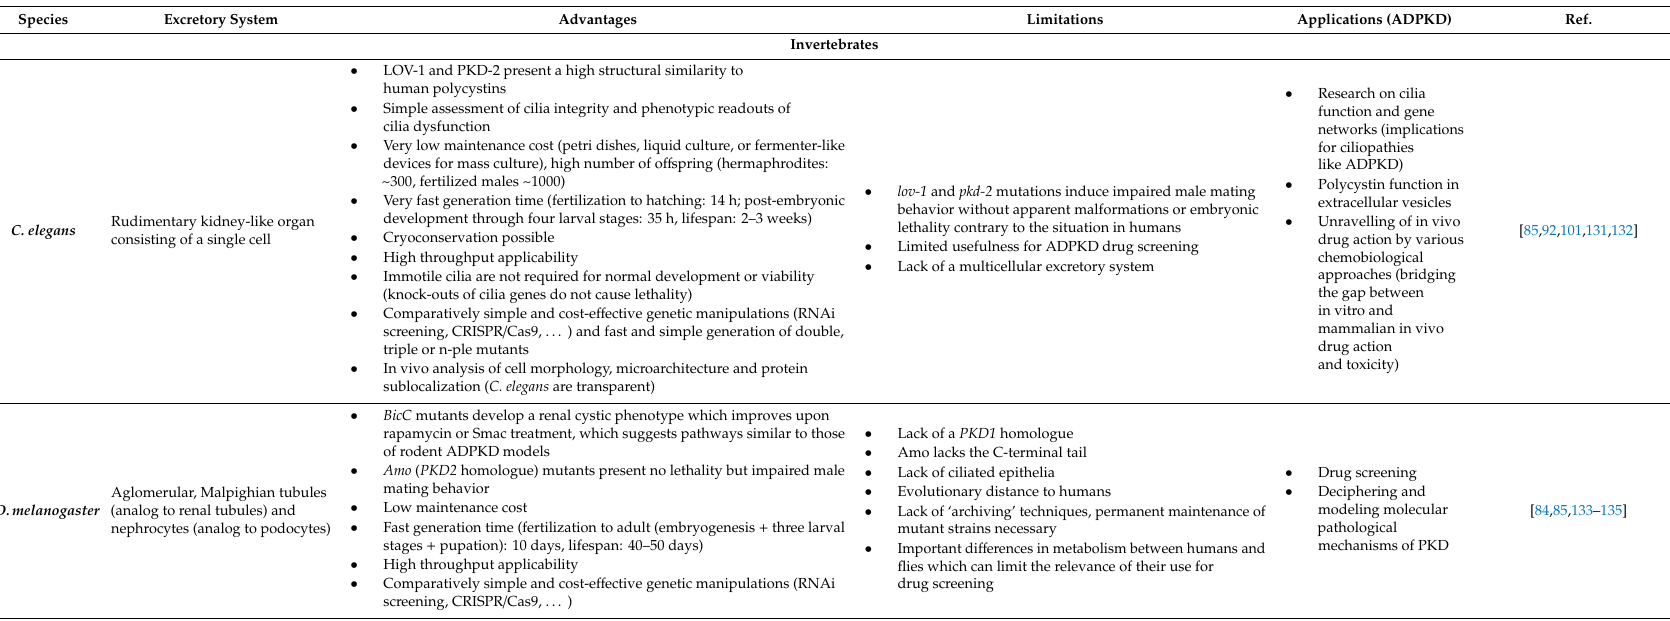
Table 2. Overview of the advantages and limitations of invertebrate and lower vertebrate ADPKD